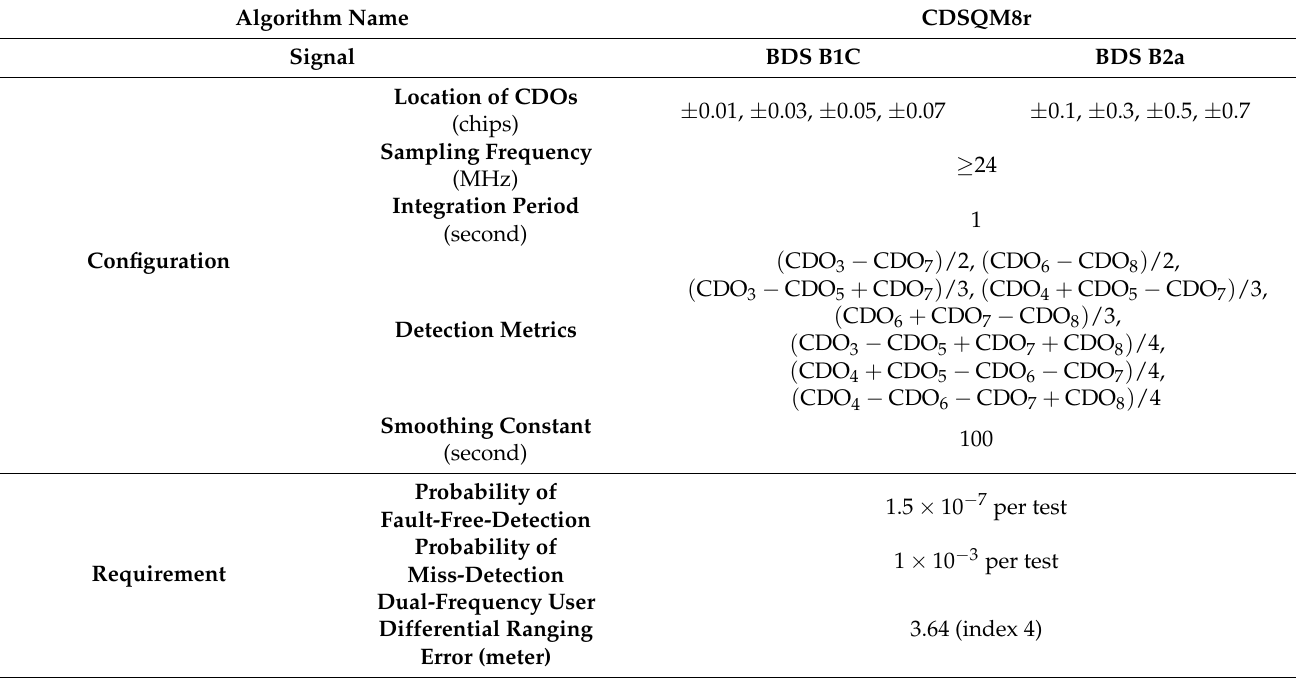
Table 5. The CDO-based SQM algorithm for BDS B1C/B2a signals toward DFMC